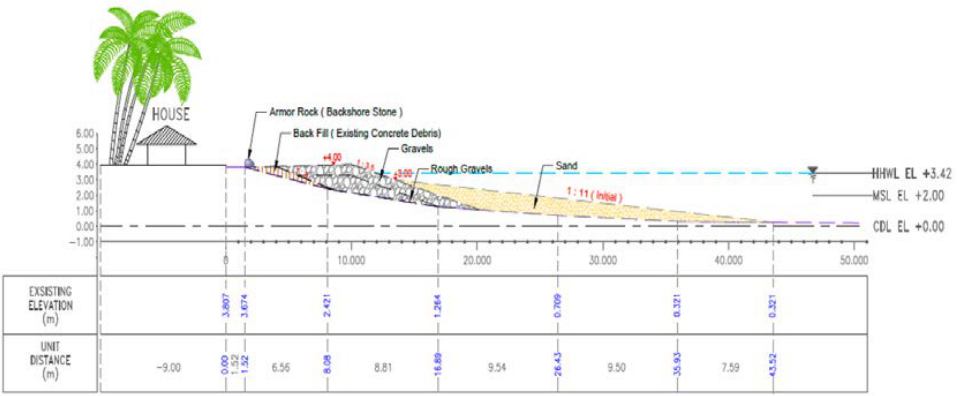
Figure 2. Gravel nourishment typical cross section on the Fongafale shore.